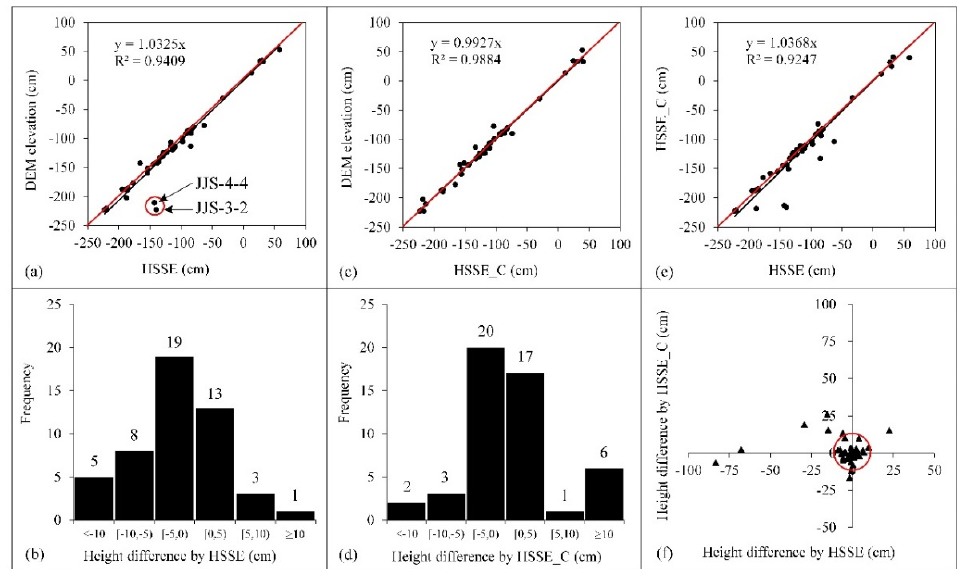
Figure 12. The comparison of the HSSE with the DEM height of the terrain. ( a ) The linear correlation between the DEM elevation and the HSSE. ( b ) The frequency histogram showing the range of height difference by HSSE. ( c , d ) are the results between the DEM elevation and the HSSE_C. ( e , f ) are the linear correlation and the spatial distribution of height difference between the HSSE and HSSE_C.